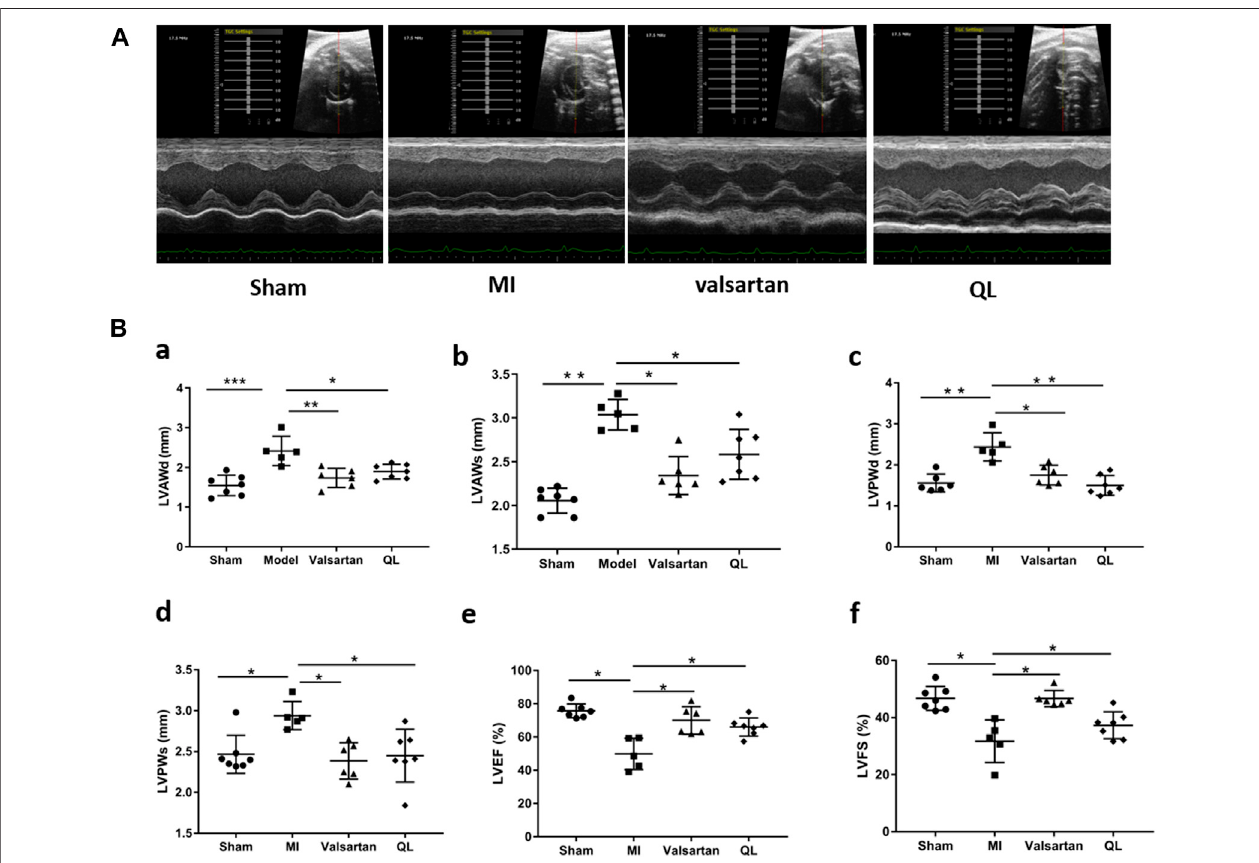
FIGURE 1| QL protected cardiac functions in HF. (A) Representative echocardiograms of rats in four groups. (B) Comparison of echocardiography parameters in the four groups. LVAWd: LV end-diastolic anterior wall thicknesses, LVAWs: LV end-systolic anterior wall thicknesses, LVPWd: LV end-diastolic posterior wall thicknesses, LVPWs: LV end-systolic posterior wall thicknesses, LVEF: LV ejection fraction, and LVFS: LV fractional shortening. The data are the mean ± standard deviation ( (cid:1) x ± s ) (n = 5, 6, or 7 per group), * p < 0.05, ** p < 0.01, and *** p < 0.001.